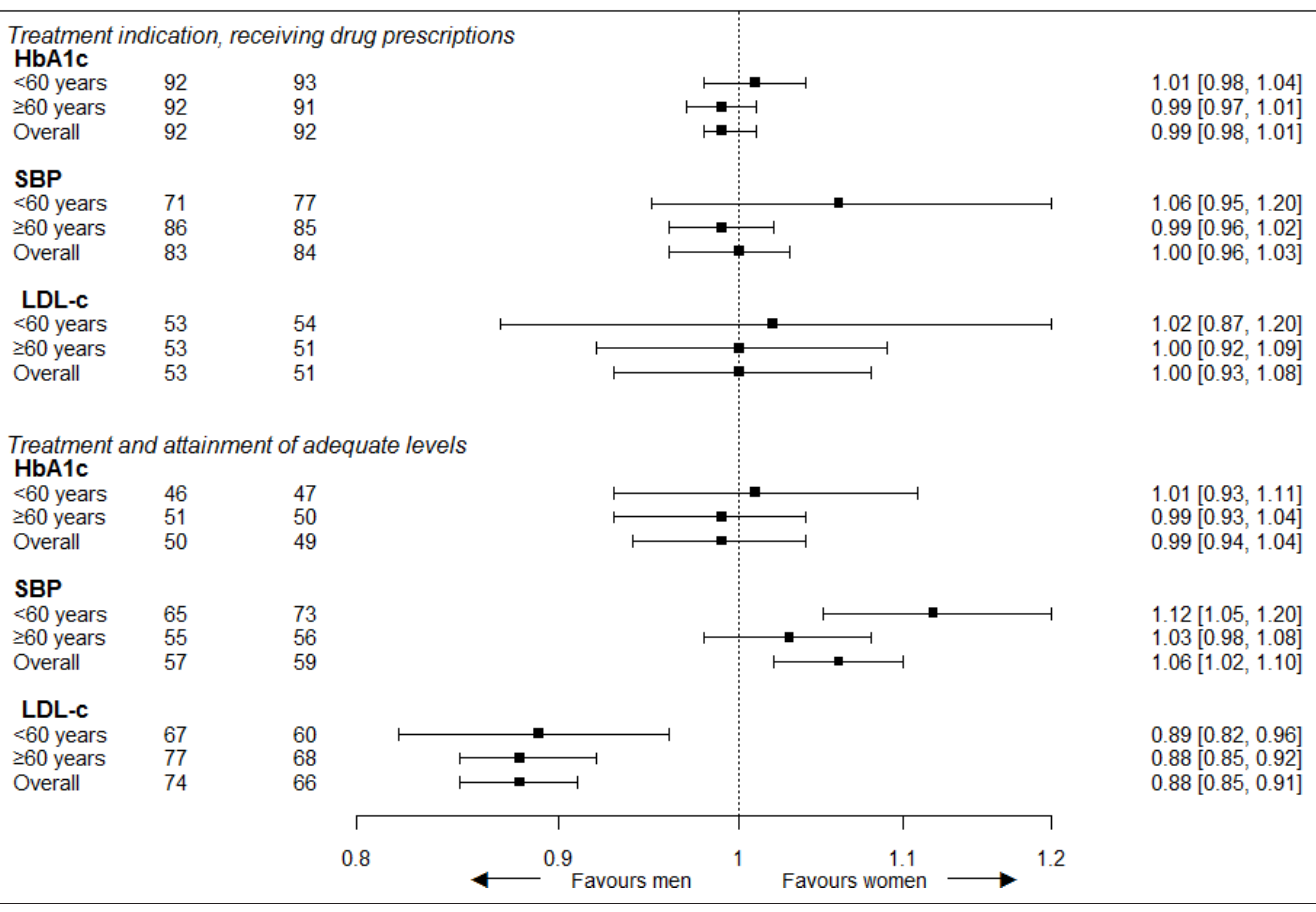
Figure 3 Women-to-men risk ratios for treatment and control of cardiovascular risk factors. The analyses are adjusted for age. Men = reference